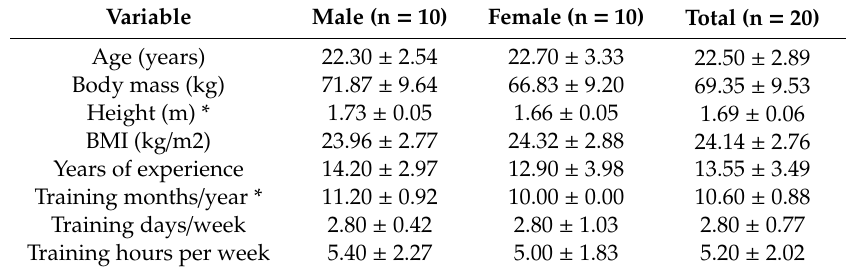
Table 1. Demographic and sport data of the Spanish National Selection inline-hockey players a